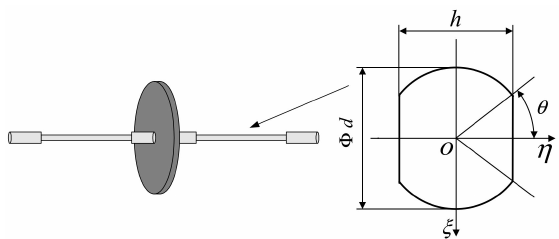
Figure 13. Schematic diagram of the asymmetric rotor.